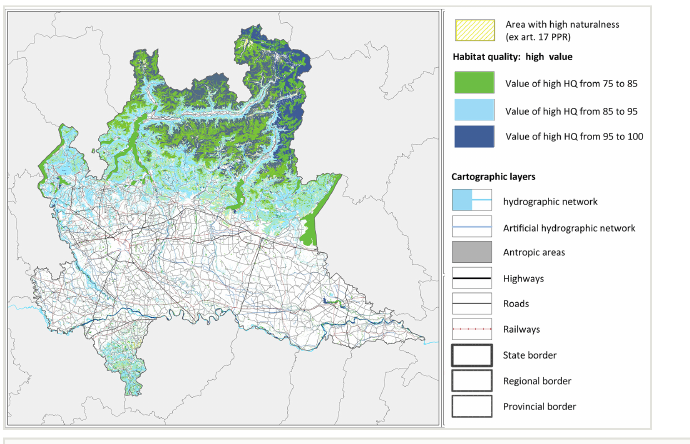
The HQ indicator was used to re-shape the protected areas designated by the regional law (art. 17). The high natural areas identi fi ed with the InVEST model follow more or less the existent delineation, of areas with an altitude of less than 1,600 meters and other surfaces located at an altitude of above 1,600 meters, where Habitat Quality values are not generally high.